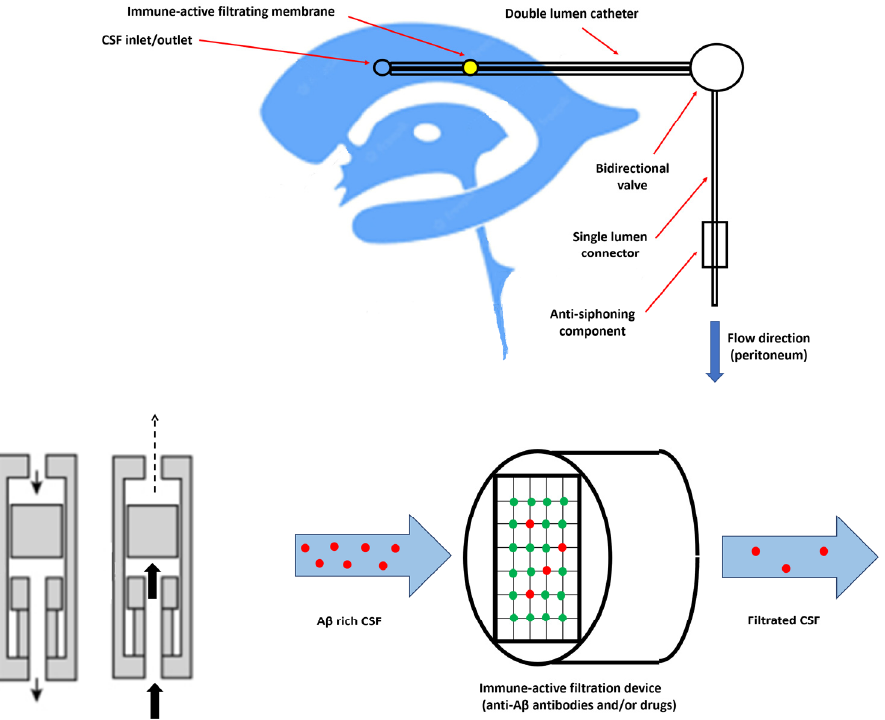
Figure 3. The proposed design of a CSF immune filtration device. A siphon-resistant valve impedes antigravitational flow, when the patient changes body position. Detailed view of the immune-active filtrating membrane: specific anti-A β drugs and/or antibodies (green dots) bind A β (red dots) from the CSF.